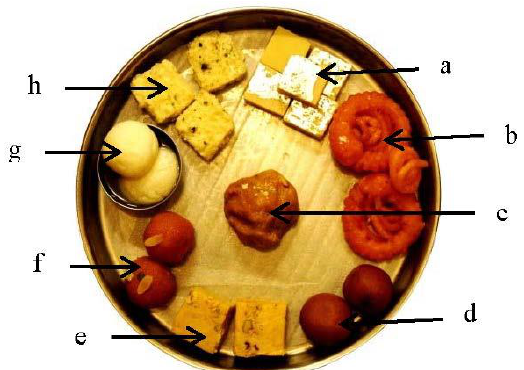
Figure 10. Photograph of commonly consumed North Indian